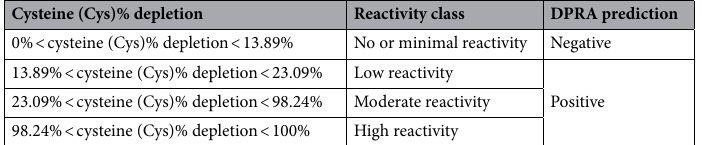
Table 4. Cysteine 1:10-only prediction model .